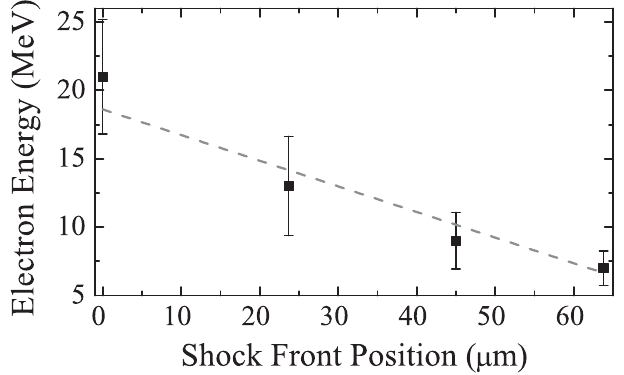
FIG. 3. Variation of electron energy with the position of the density transition. The grey dashed line shows a linear fit yielding an acceleration gradient ’ 190 GV = m